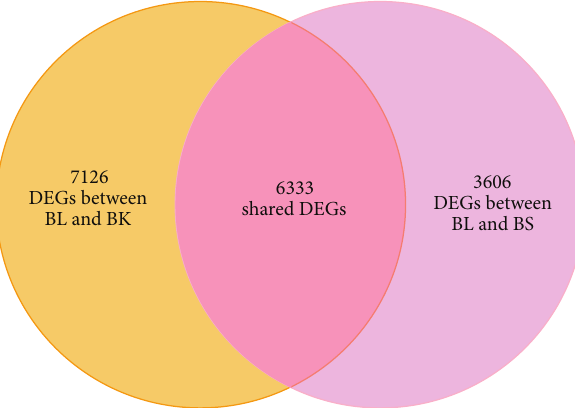
Figure 4: Venn diagram of shared DEGs between BL versus BK and BL versus BS